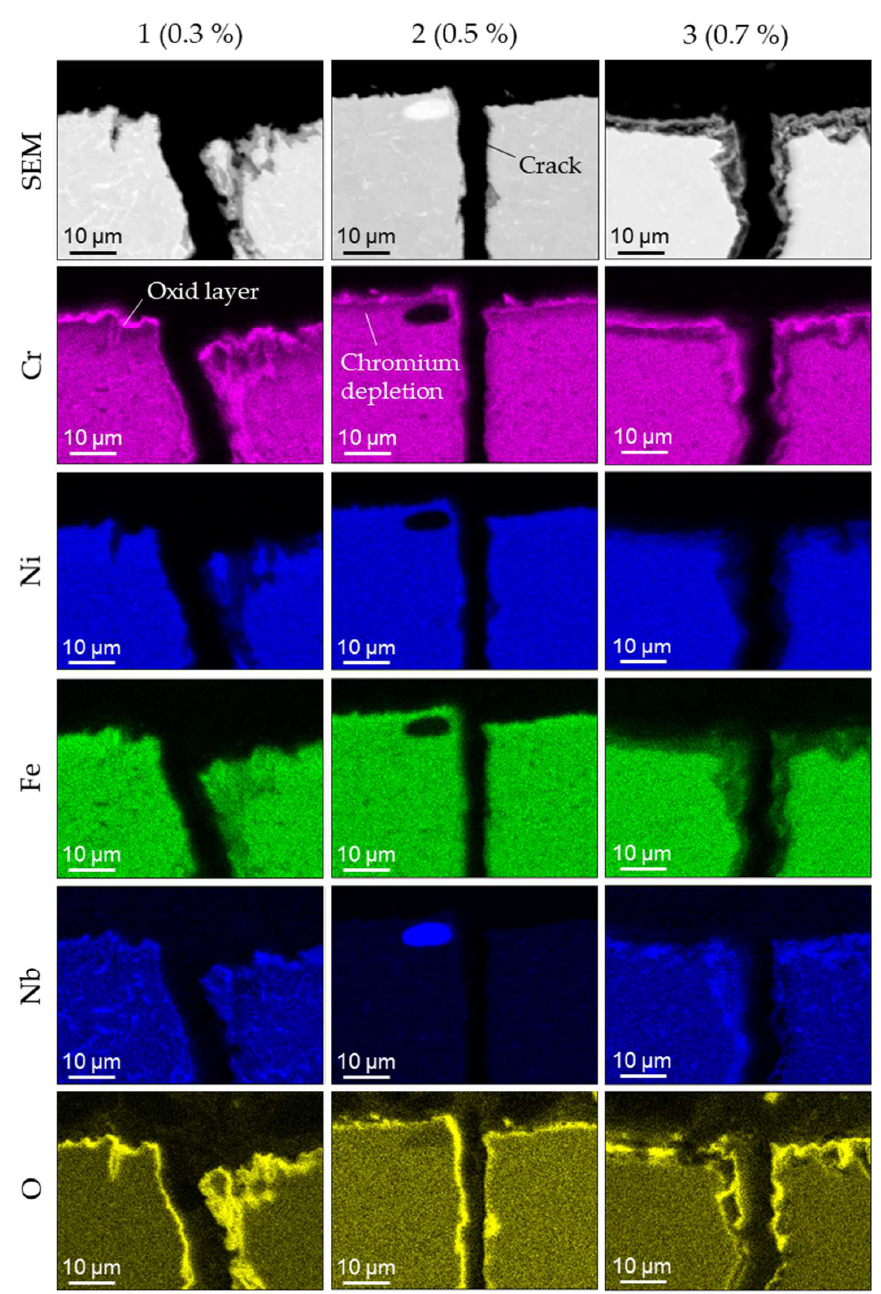
Figure 10. SEM images and EDX mappings for the elements chromium, nickel, iron, niobium, and oxygen .